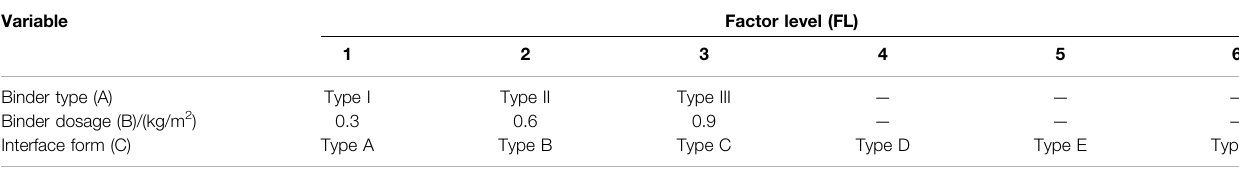
TABLE 4 | Experimental variables and the levels for internal conditions.